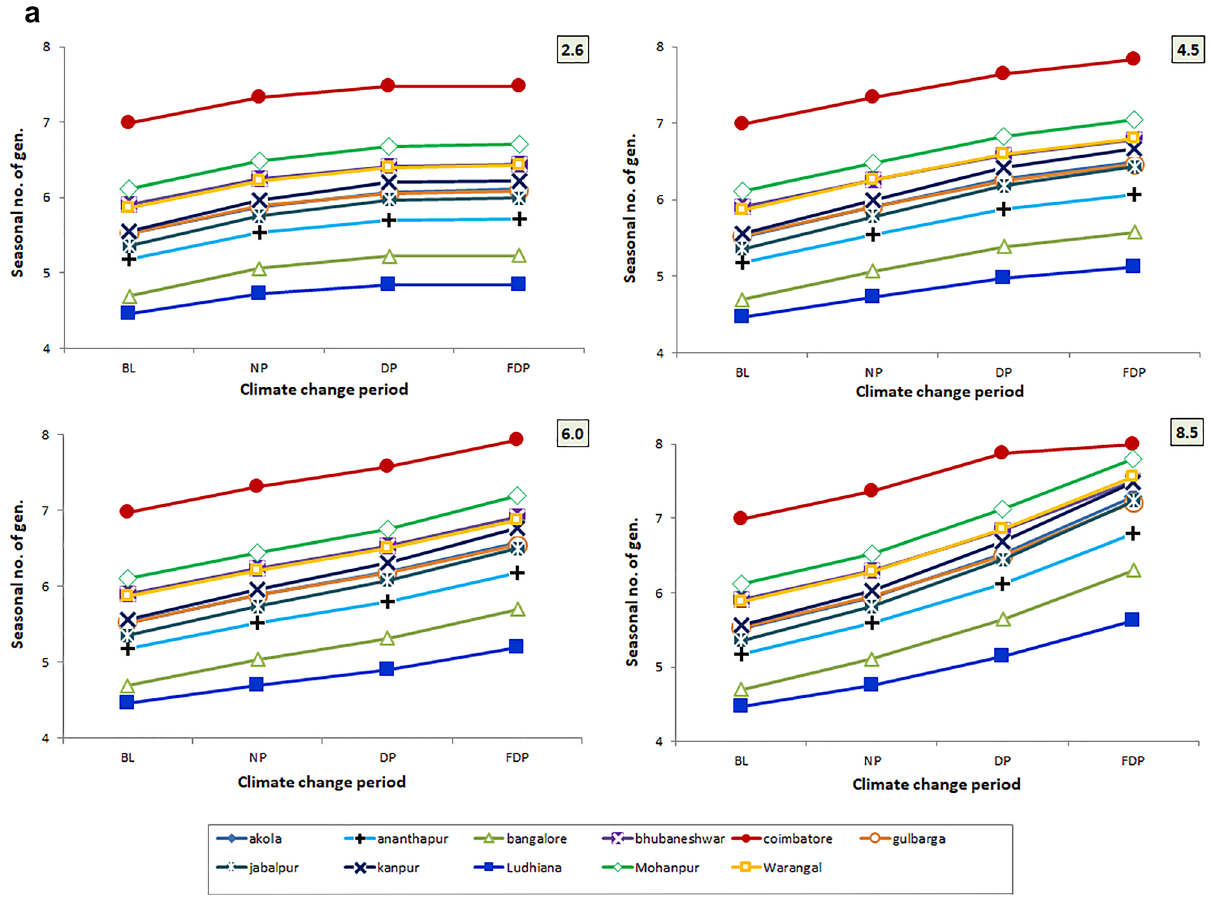
Figure 6. ( a ) Trend in no. of gen. in crop season across 4 RCPs and 4 CCPs. ( b ) Trend in gen. time in crop season across 4 RCPs and 4